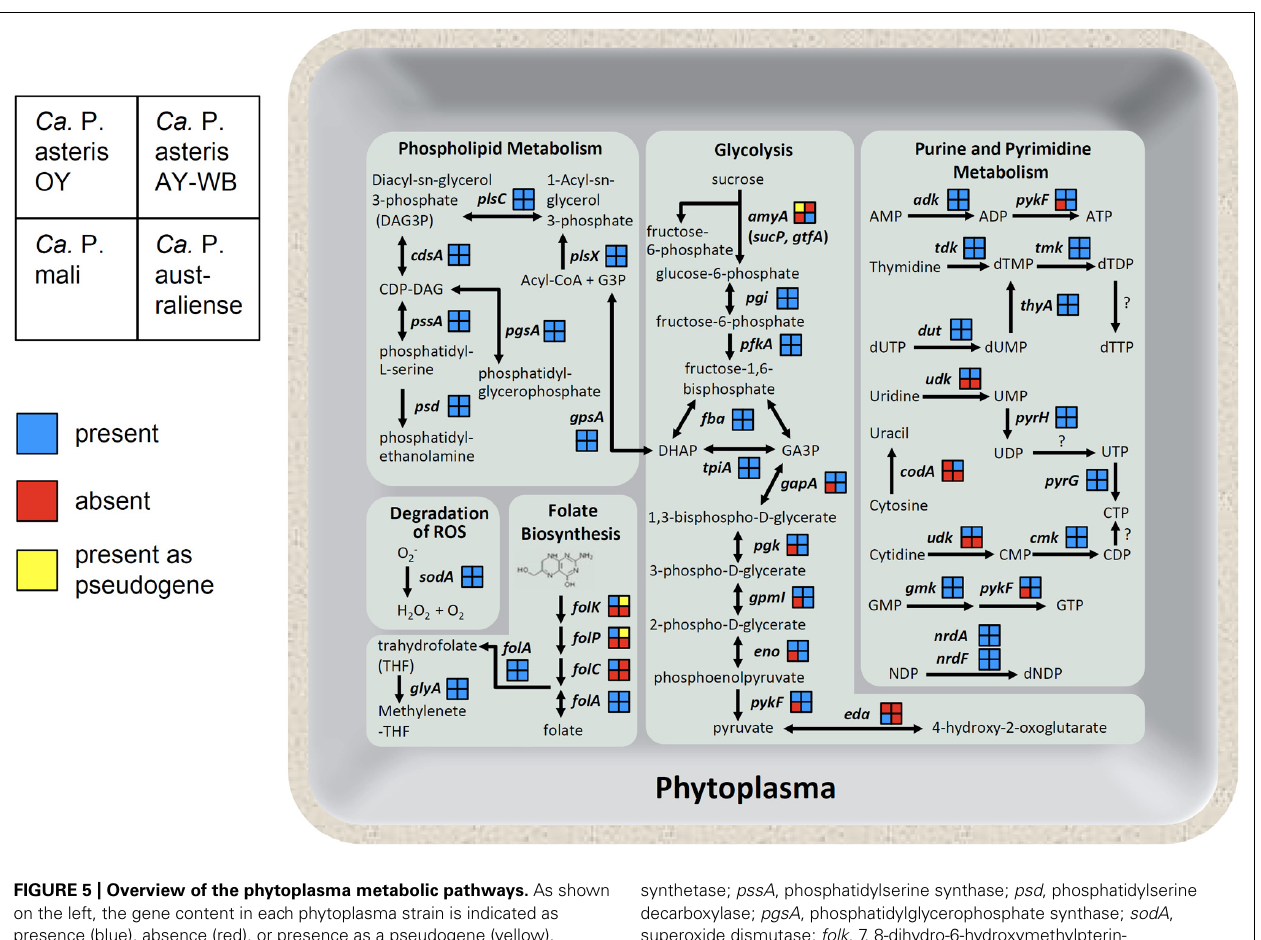
FIGURE 5 | Overview of the phytoplasma metabolic pathways. As shown on the left, the gene content in each phytoplasma strain is indicated as presence (blue), absence (red), or presence as a pseudogene (yellow). Abbreviated gene names are as follows: amyA , sucrose phosphorylase; pgi , glucose-6-phosphate isomerase; pfkA , 6-phosphofructokinase; fba , fructose bisphosphate aldolase; tpiA , triosephosphate isomerase; gapA , glyceraldehyde-3-phosphate dehydrogenase; pgk , 3-phosphoglycerate kinase; gpmI , phosphoglyceromutase; eno, enolase; pykF , pyruvate kinase; eda , 2-dehydro-3-deoxyphosphogluconate aldolase; gpsA , glycerol 3-phosphate dehydrogenase; plsX , fatty acid/phospholipid biosynthesis enzyme; plsC , 1-acyl-sn-glycerol-3-phosphate acyltransferase; cdsA , CDP-diglyceride beta